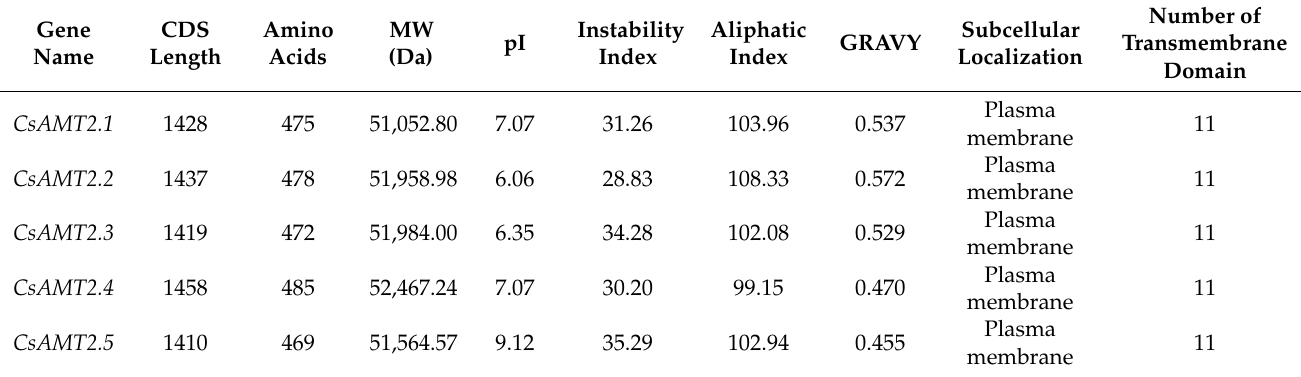
Table 1. Characterization of identified CsAMT2 proteins in tea